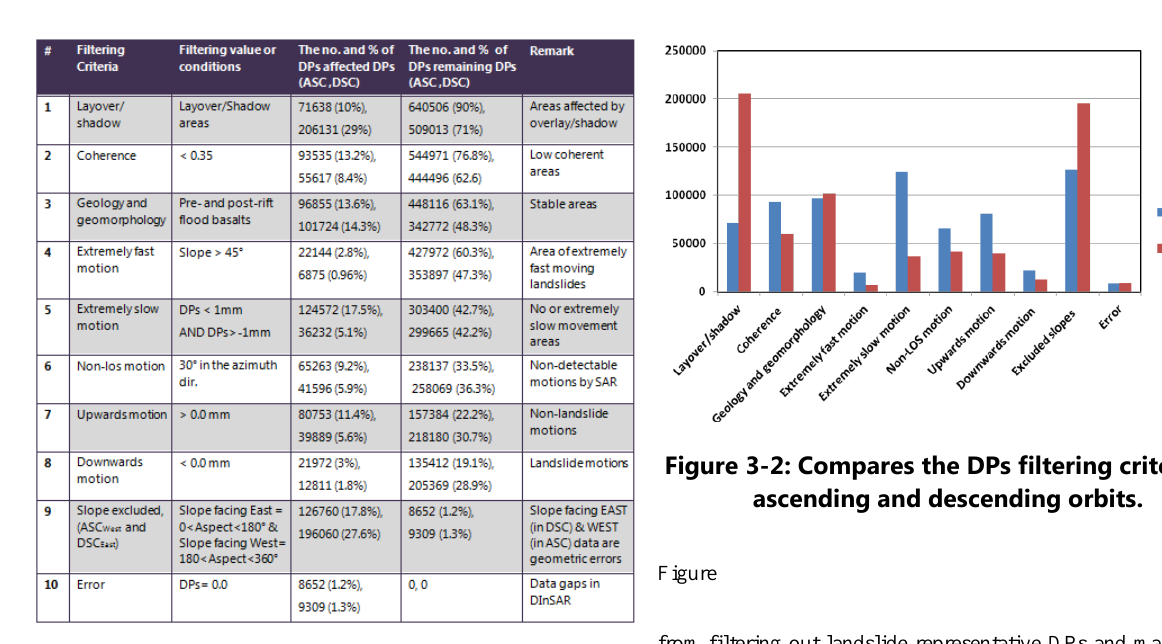
Table 1. Summary of the GIS-MCFA analysis The use of both ASC and DSC data enhanced the coverage of landslide detection, as ascending is suitable for slope facing towards to east (eastern slopes) and descending for western slopes (Notti et al. 2010, Colesanti et al. 2006). Using the two applied acquisition geometries in Dessie, it was possible to detect around 32% of landslide in ascending and 12.5% of landslide in descending orbits. The application of ASC and DSC data enabled the investigation of the entire area of interest.